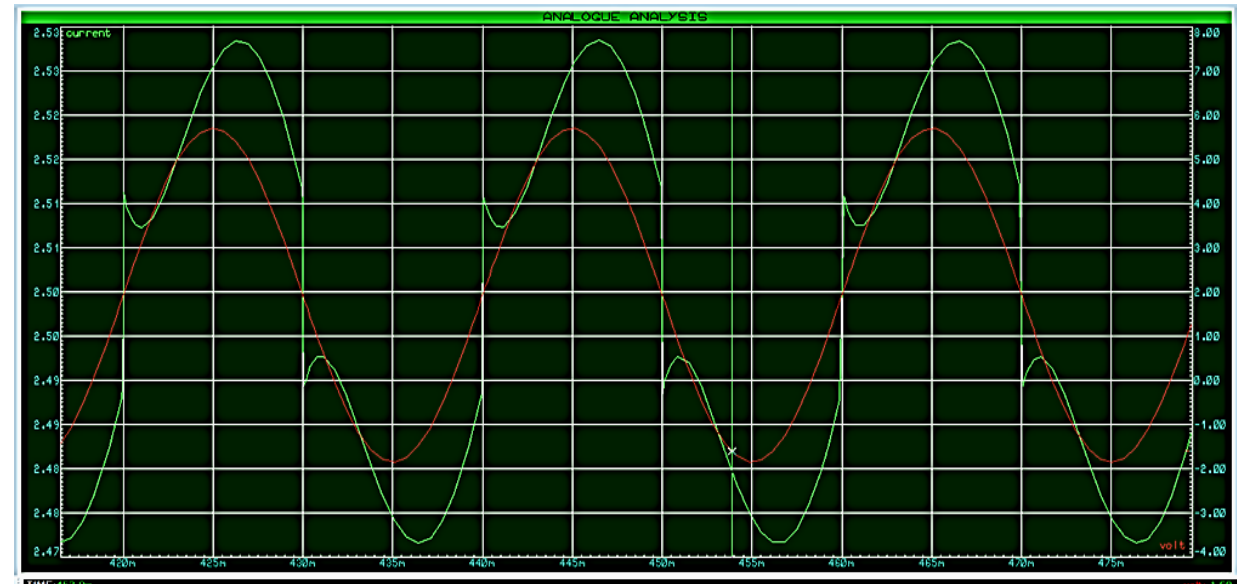
Figure 14. Current and voltage waveform of the nonlinear.